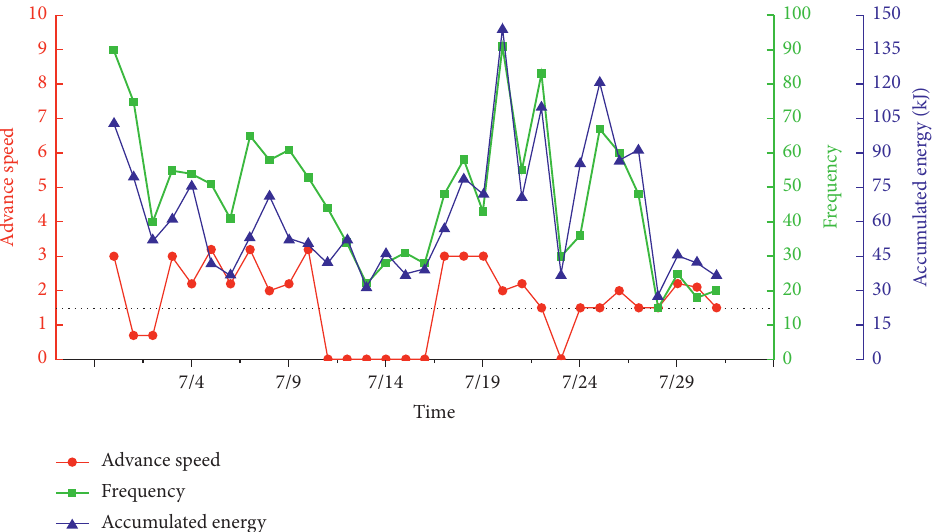
Figure 10: Relationship between the microseismic activity and the advance